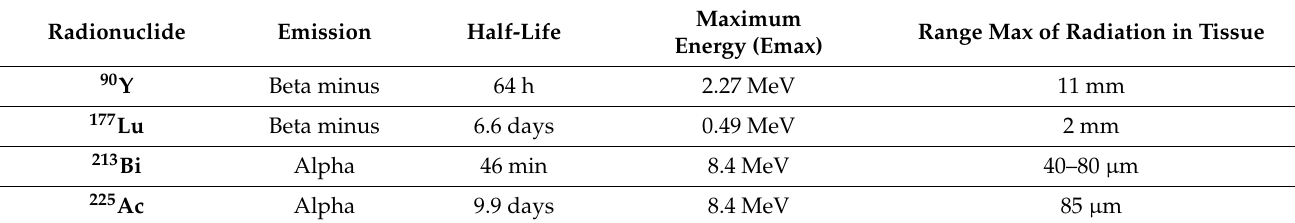
Table 2. Physical characteristic of radionuclides used for peptide receptor radionuclide therapy (PRRT) in primary brain tumors